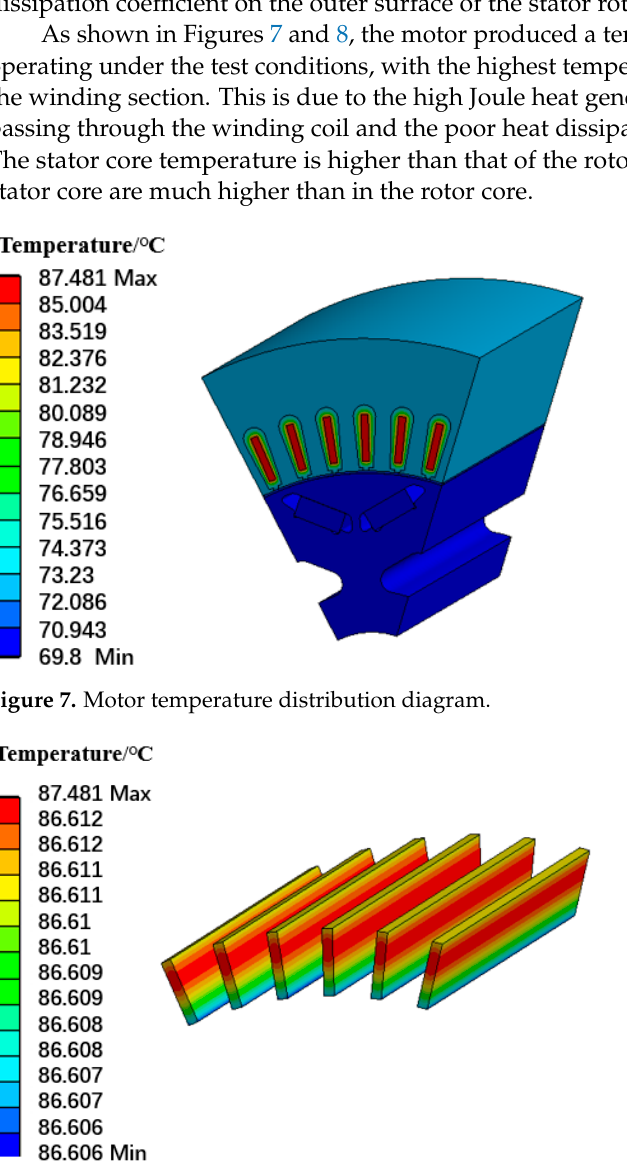
Figure 8. Stator winding temperature distribution diagram.